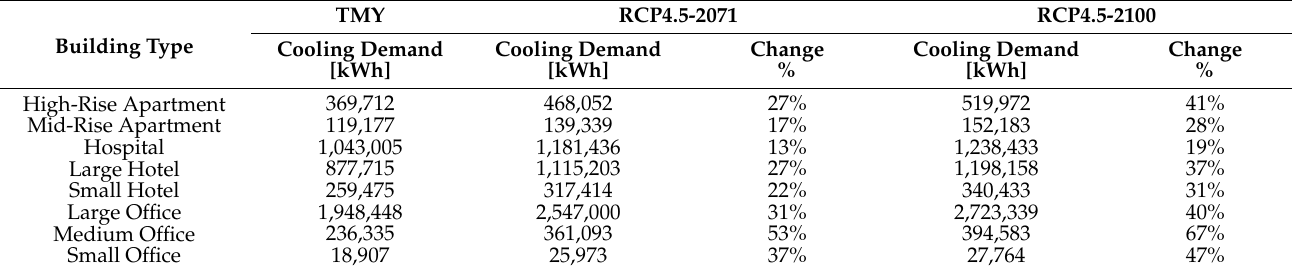
Table 5. Climate change impact on the annual cooling